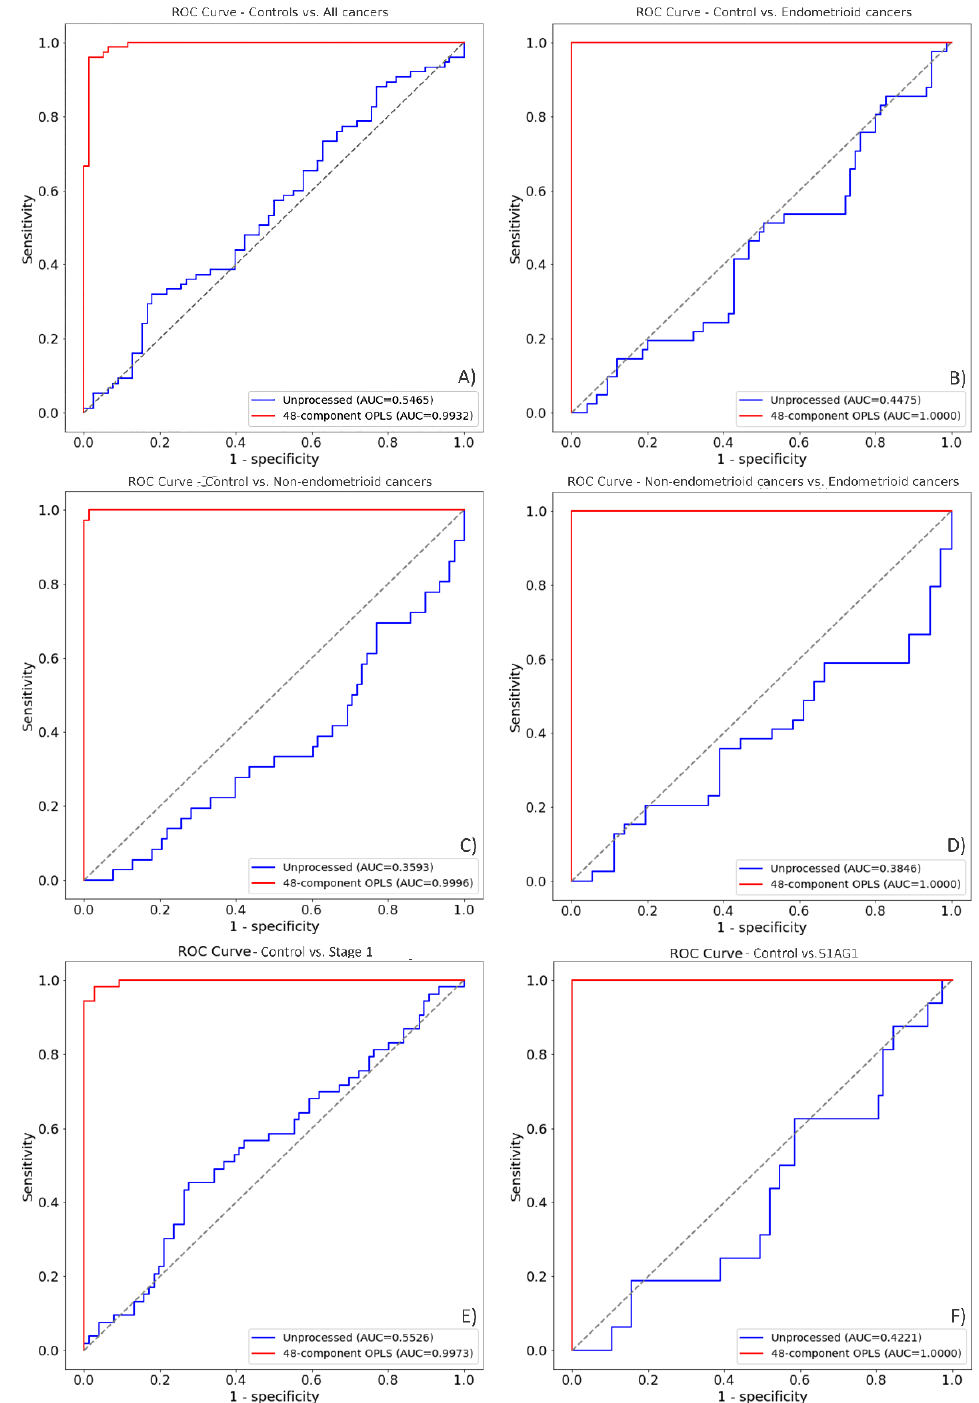
Figure 3. Receiver operating characteristic (ROC) curves after the application of OPLS-PLS-DA. Figures ( A – F ) illustrate the ROC curve of OPLS-PLS-DA processed data (red curves) and unprocessed data (blue curves). These figures demonstrate how the discrimination analysis would behave if unprocessed with OPLS; the models are suboptimal in their discriminatory ability when OPLS is not applied as pre-processing method. The subplots from this figure show the following comparisons: ( A ) Controls ( n = 110) vs. all cancers ( n = 109). ( B ) Controls ( n = 110) vs. endometrioid cancers ( n = 57). ( C ) Controls ( n = 110) vs. non-endometrioid cancers ( n = 52). ( D ) Endometrioid cancers ( n = 57) vs. non-endometrioid cancers ( n = 52). ( E ) Controls ( n = 110) vs. stage I cancers ( n = 75). ( F ) Controls ( n = 110) vs. stage IA grade 1 cancers ( n = 22).